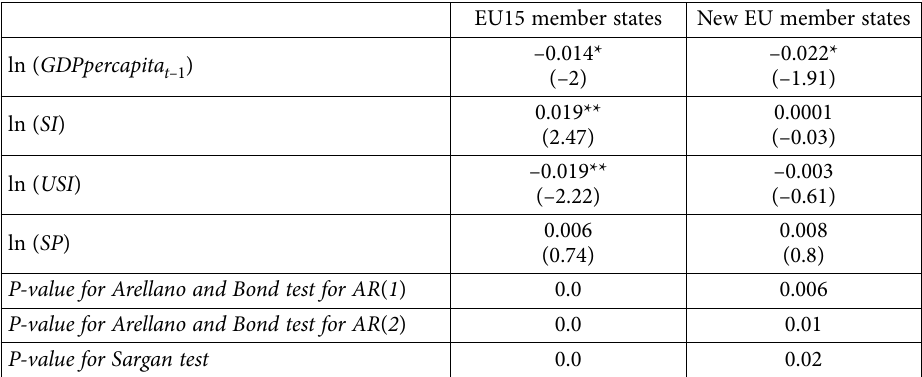
Table 2. Testing the impact of skilled and unskilled immigration on growth based on a dynamic panel model 1 for EU15 and the new EU member states (source: author own calculation) Dependent variable: ln ( gGDPpercapita